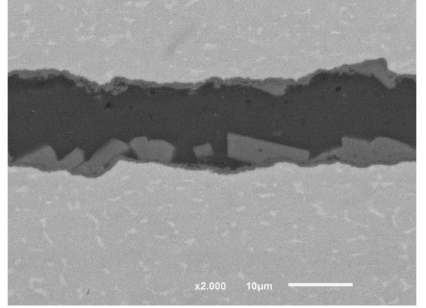
Figure 10. SEM images (BSE) of Ti/Al-1Si/Ti ultrasonic-assisted brazed joint at 665–670 ◦ C without holding time. The intermetallic formation and precipitation of TiAl 3 increased due to the very small gap distance between the faying surfaces of the